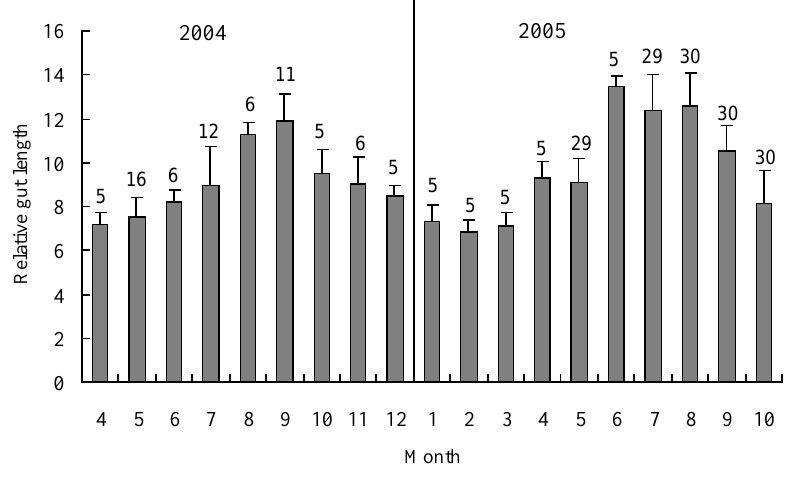
FIGURE 4. Seasonal changes of RGL of silver carp during April 2004 and October 2005. Error bars represent 1 S.D. Values above the bars indicate the number of samples.